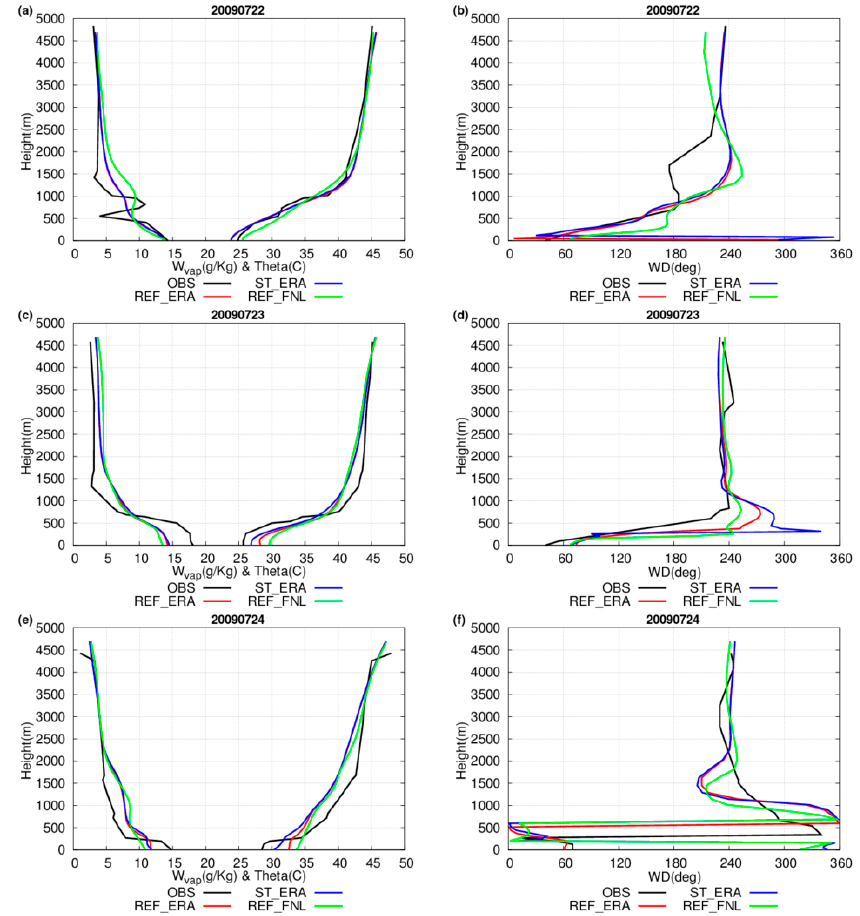
Figure 11. ( a – f ) Observed (black) and simulated vertical profiles, considering the REF_ERA, ST_ERA and REF_FNL simulations, for potential temperature (°C) and water vapor mixing ratio (g/kg) in MUR sounding station for the whole simulation period ( left ): 22 July ( a ); 23 July ( c ) and 24 July 2009 ( e ); and wind direction ( right ): 22 July ( b ); 23 July ( d ) and 24 July 2009 ( f ) at 00 UTC.